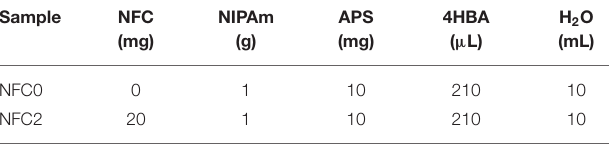
TABLE 2 | Compositions of hydrothermal synthesized intelligent hydrogels.